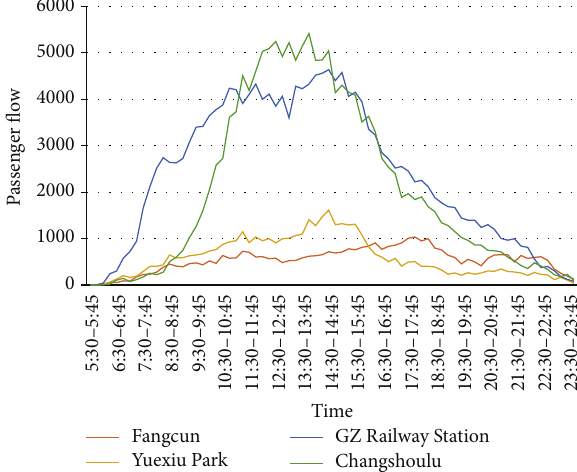
Figure 3: Passenger flow’s temporal distribution of typical destina- tions on January